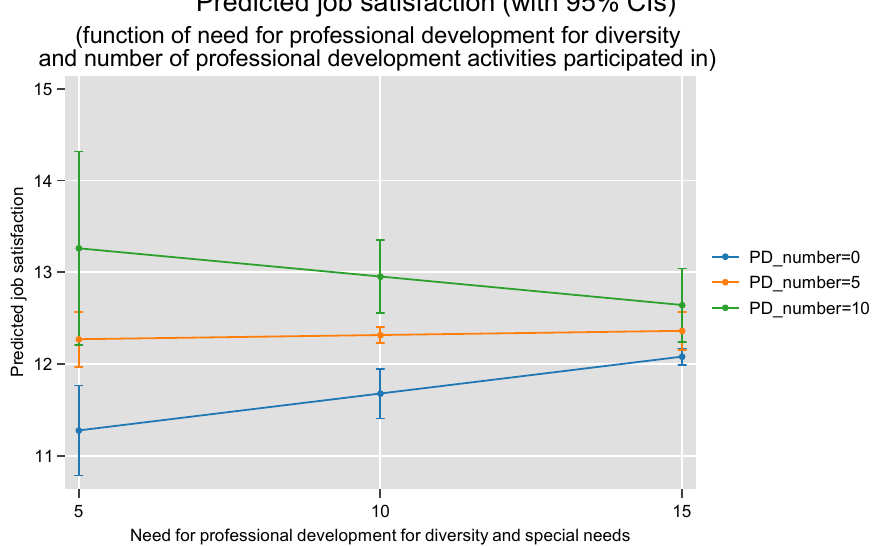
Figure 1. Predicted job satisfaction as a function of the need for professional development for diversity and special needs and the number of professional development activities participated in.